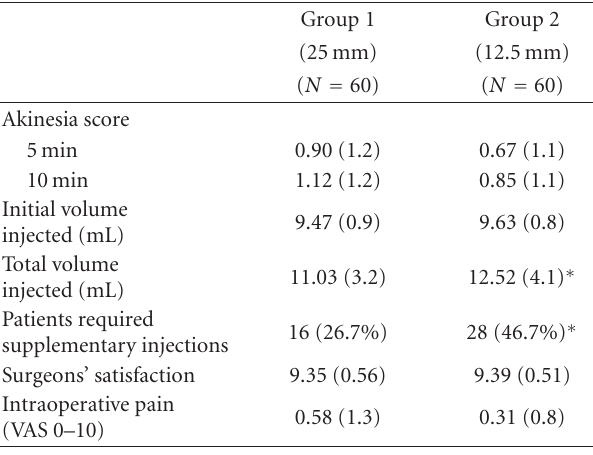
Table 2: Clinical